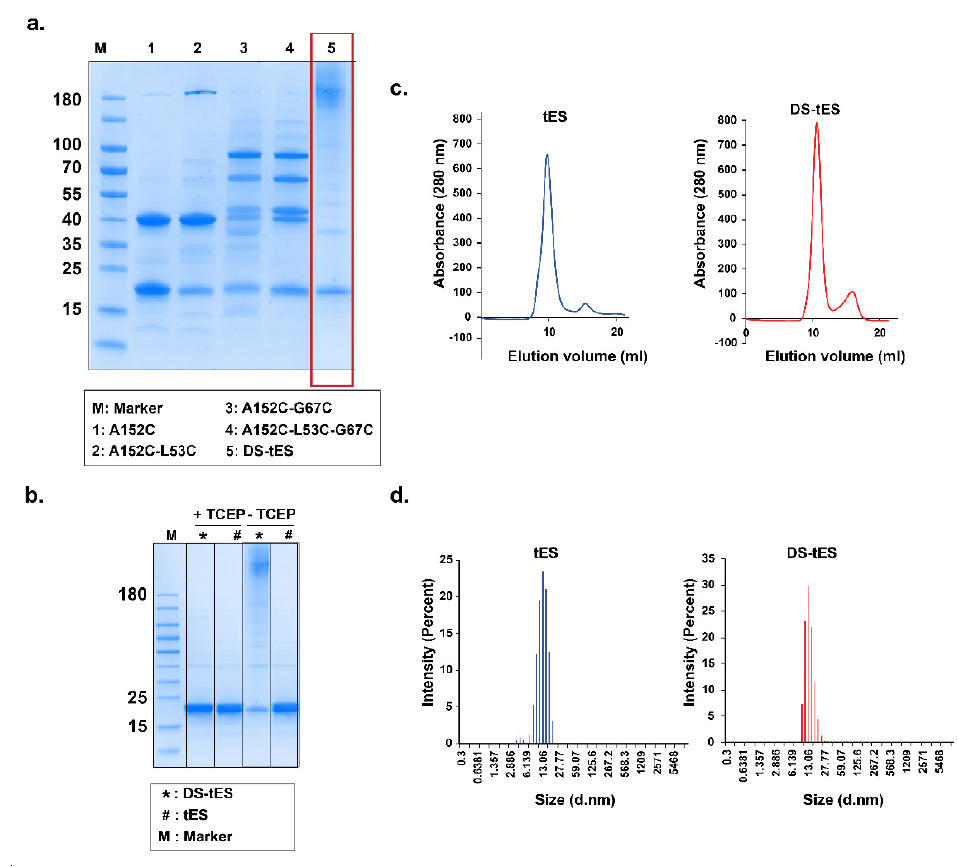
Figure 2. ( a ) Sequential engineering of DS-tES. Non-reducing SDS-PAGE of the selected mutants. ( b ) SDS-PAGE analysis of DS-tES and tES in the absence or presence of TCEP. ( c ) Size-exclusion chromatography of tES and DS-tES with similar elution profiles. ( d ) Hydrodynamic diameter measurements of tES and DS-tES using dynamic light scattering studies.